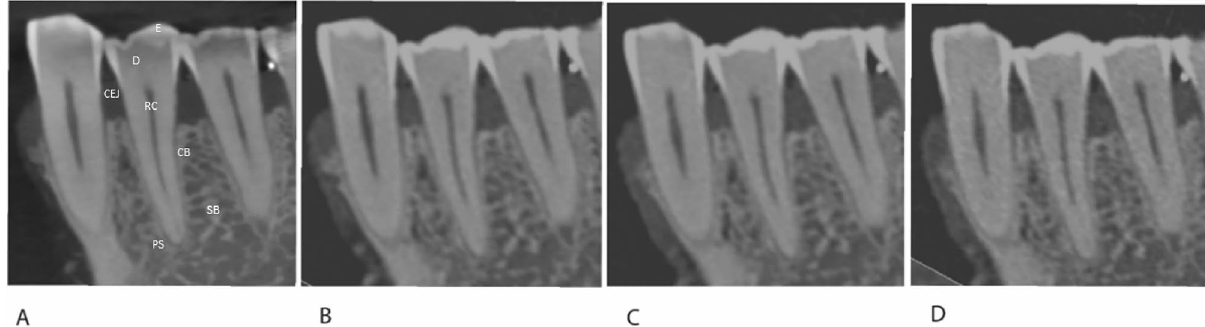
Figure 1. Sagittal reformations of the same region: Teeth 33, 34 and 35 in ( A ) CBCT ( B ) PCCT HD ( C ) PCCT MD ( D ) PCCT LD; D dentine, E Enamel, CEJ Cemento-Enamel-Junction, RC root canal, PS periodontal space, CB cortical bone, SB spongious bone. (C = 1535 HU, W = 8504